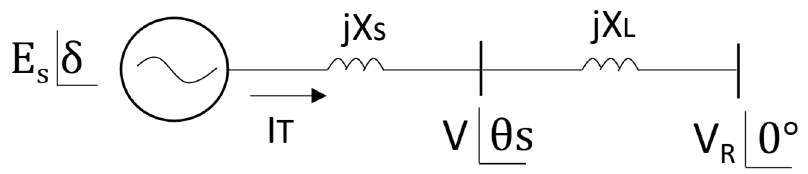
Figure 3. Equivalent system diagram (generator and infinite bus).